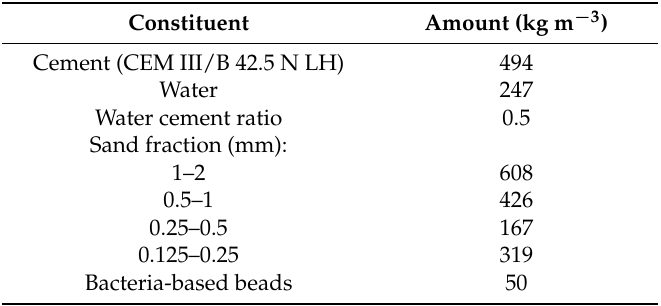
Table 2. Mix-design for the bacteria-based self-healing cementitious